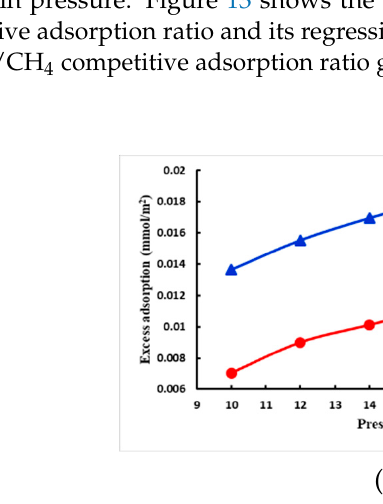
Figure 12. The adsorption capacity of two fluids ( a ): Total adsorption capacity, ( b ): Excess adsorption capacity.